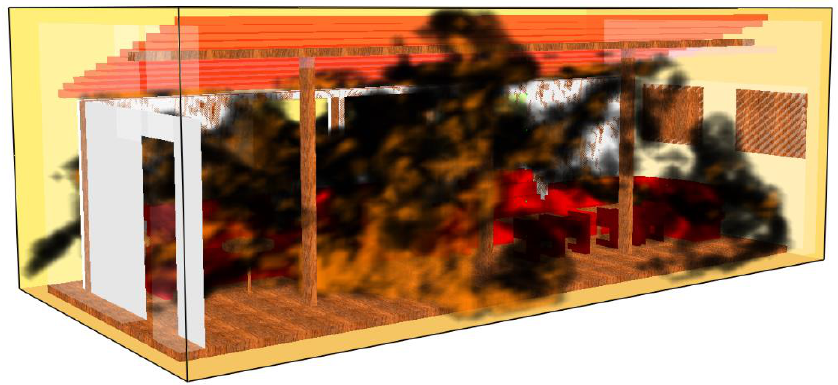
Figure 16. Generalized fire spreading throughout the restaurant floor.